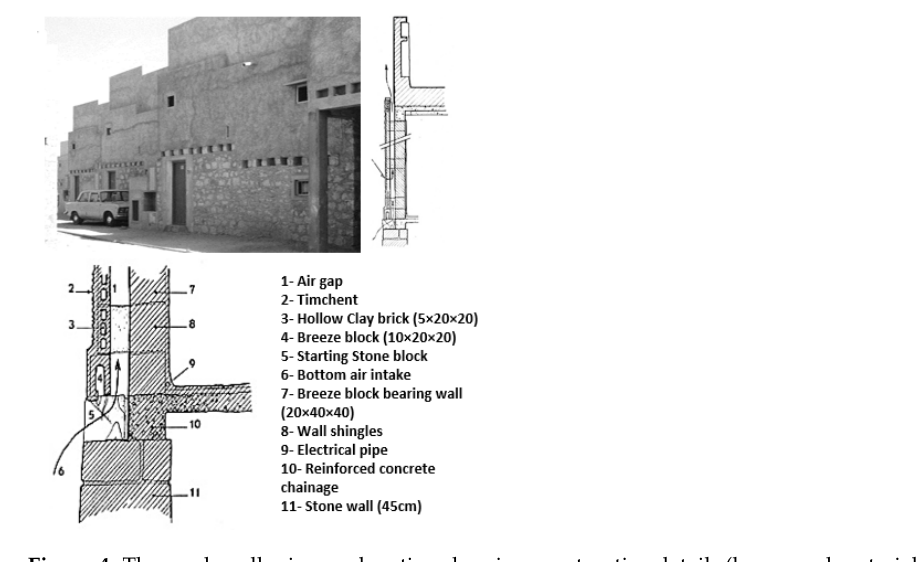
Figure 4. The mask wall: view and section showing constructive details (layers and materials) [44,47].